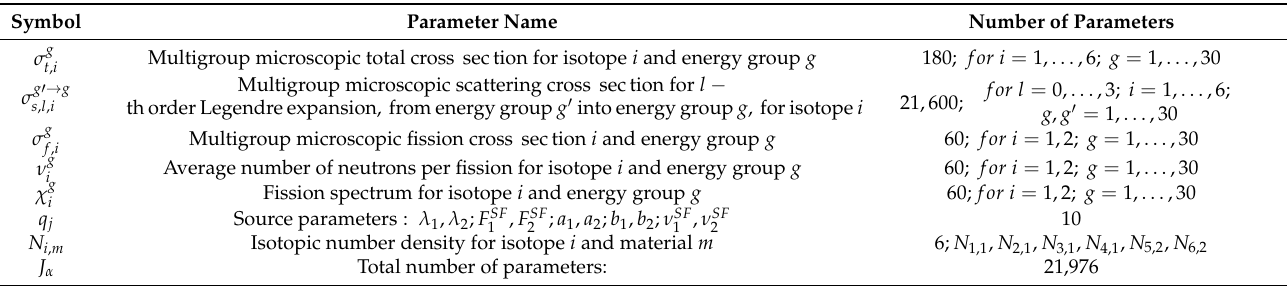
Table 2. Summary of imprecisely known parameters for the PERP